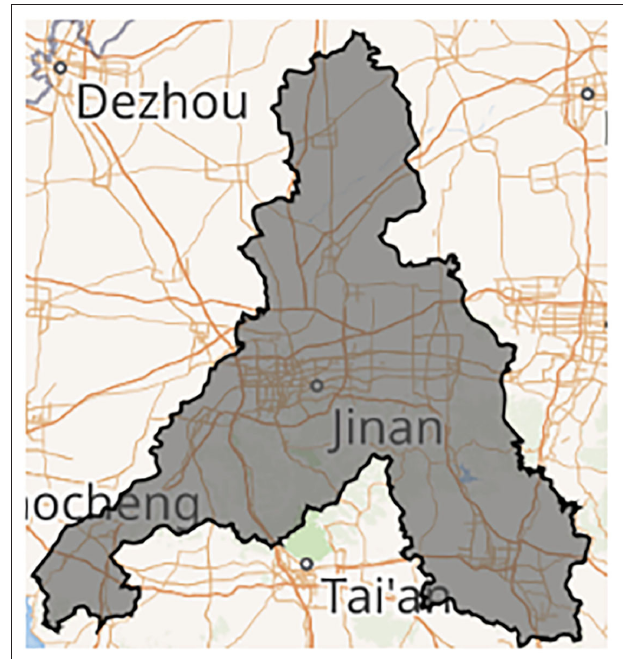
FIGURE 1 | Location of research